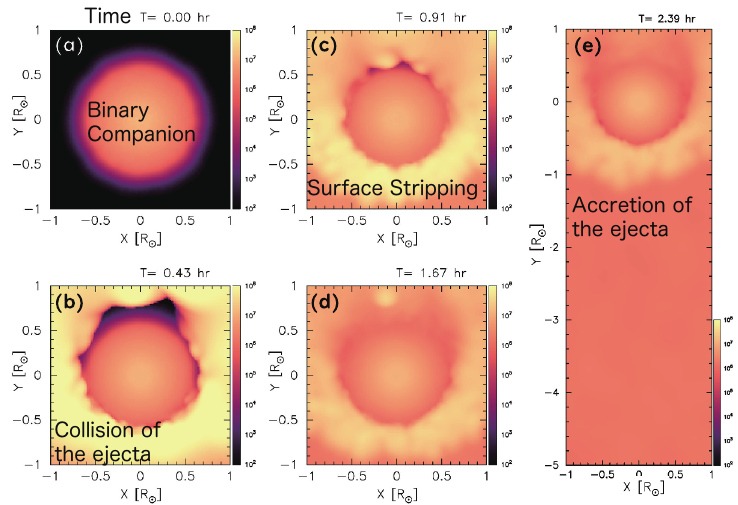
Figure 2. The snapshot of the SPH simulation of the collision between the supernova ejecta of a 15 M ⊙ star and a 0.8 M ⊙ star with a distance of 0.2 au. The color contour represents the temperature in units of kelvin. Panel (e) shows the simulation box that includes the part of the colliding ejecta.